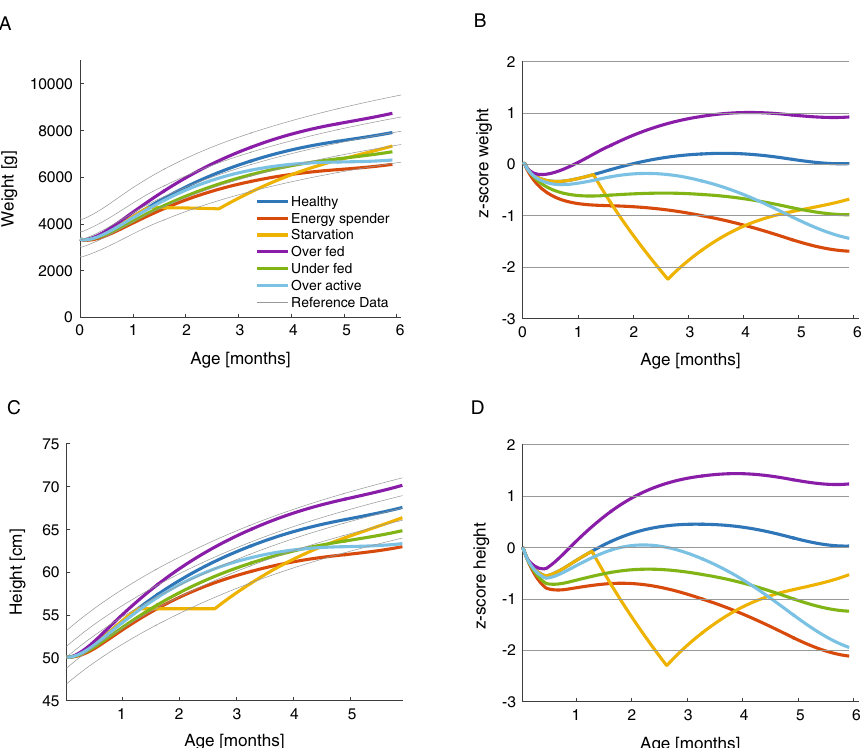
Fig. 3 Perturbations to the reference model. The Energy spender model was de fi ned by a 30% increase in the maintenance expenditure for lean mass. The “ Starved ” model had decreased milk intake to 50% from age 40 – 80 days. The overfed and underfed models had +10% and − 10% change in intake of breast milk. The over active model spent twice as much energy on physical activity. a Body weight. b z -scores of weight, the number of standard deviations from the mean. c Height. d z -scores of